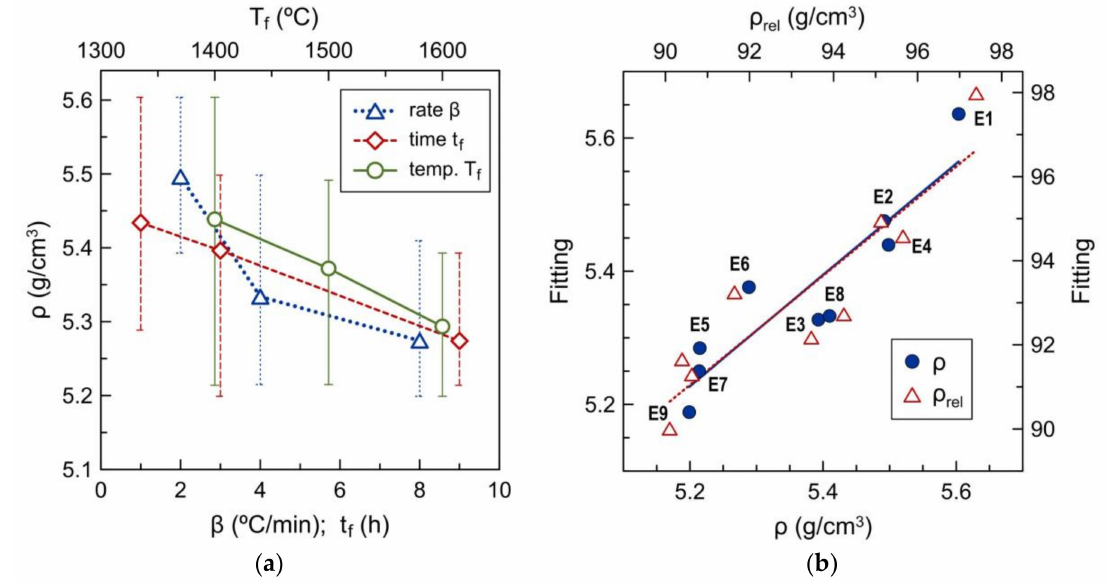
Figure 6. ( a ) Density vs. heating / cooling rate, sintering temperature and time, based on averaged results. Error bars show the lowest and highest results obtained at a given level of a specific factor; ( b ) Multivariate fitting of absolute density (closed symbols and primary axes) and relative density (open symbols and secondary